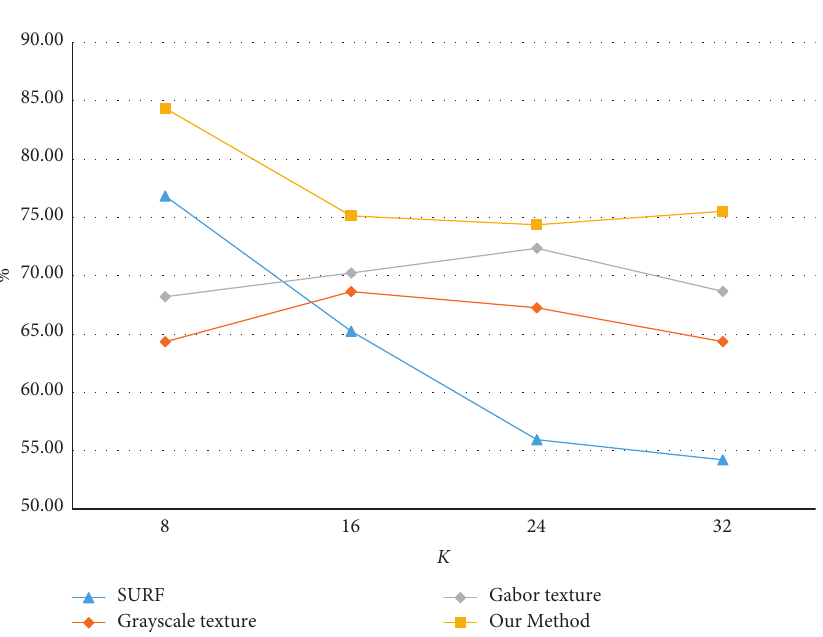
Figure 8: Comparison of features of chest medical images.